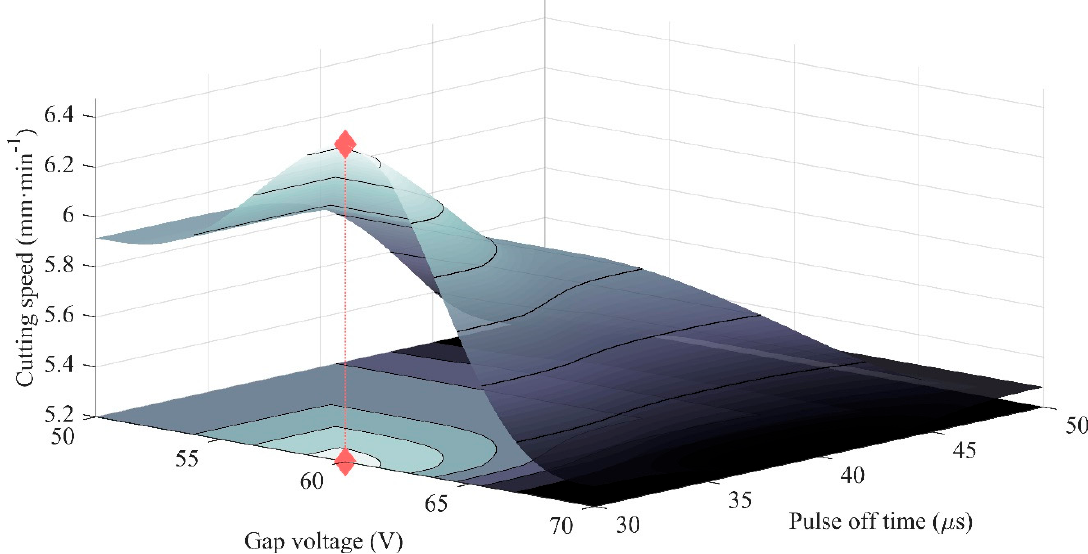
Figure 4. The prediction of cutting speed by FIS depending on the gap voltage and pulse off time with the defined optimum control surface.